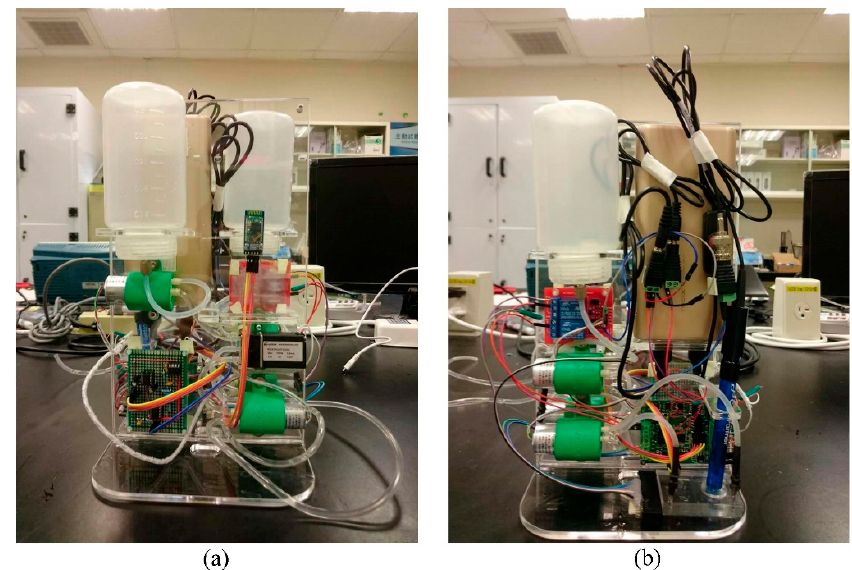
Figure 2. The experimental device diagram of the real water quality monitoring system: ( a ) front view; ( b ) back view.